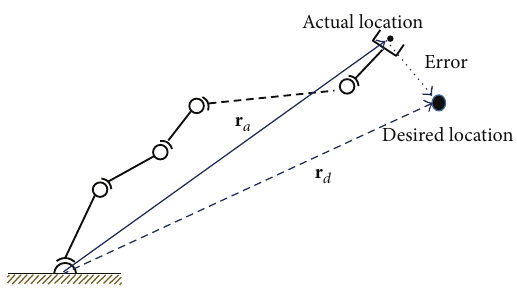
Figure 4: Schematic diagram of a serial redundant